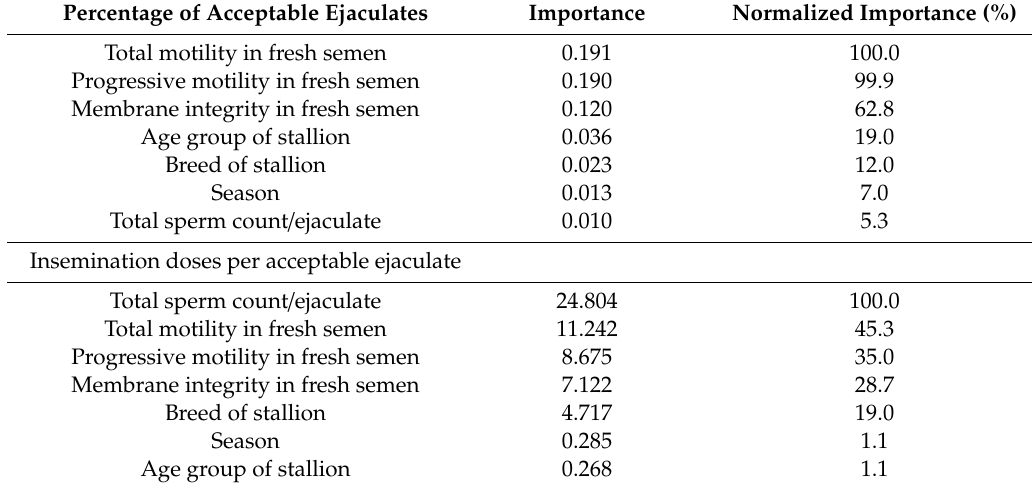
Table 4. Independent variable importance for the dependent variable percentage of acceptable ejaculates after cryopreservation and number of insemination doses per acceptable